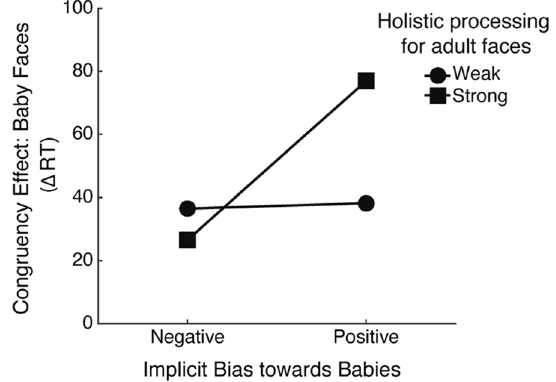
Fig. 5 Mean congruency effect for baby faces (∆RT), as a function of 1 SD above and below the means of the magnitude of holistic processing of adult faces (strong vs. weak) and implicit bias toward babies (positive vs.